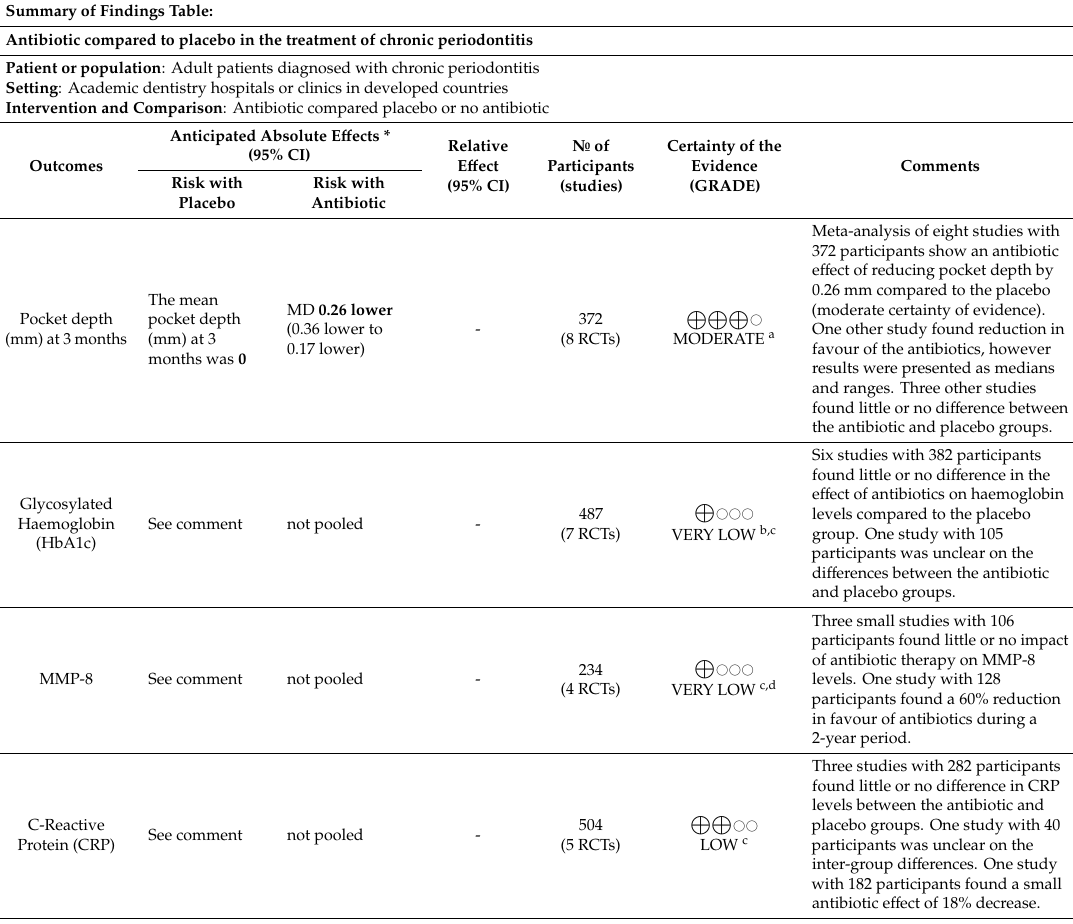
Table 2. GRADE Summary of Findings Table for studies assessing mechanical debridement with antibiotics in the treatment of periodontitis. Summary of Findings Table: Antibiotic compared to placebo in the treatment of chronic periodontitis Patient or population : Adult patients diagnosed with chronic periodontitis Setting : Academic dentistry hospitals or clinics in developed countries Intervention and Comparison : Antibiotic compared placebo or no antibiotic